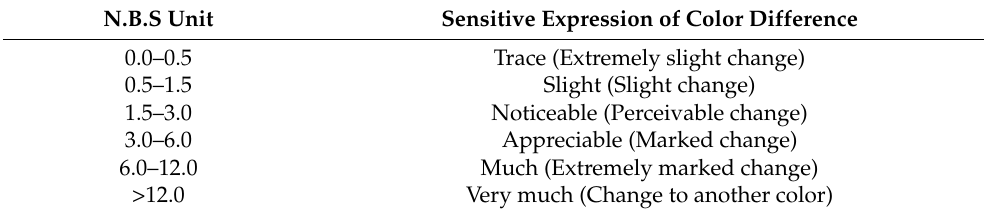
Figure 5. Color change according to heating temperature: ( a ) change in lightness ( Δ L*); ( b ) change in red/green value ( Δ a*); ( c ) change in the blue/yellow value ( Δ b*); ( d ) color difference ( Δ E*). Table 7. National Bureau of Standards (NBS) ratings.